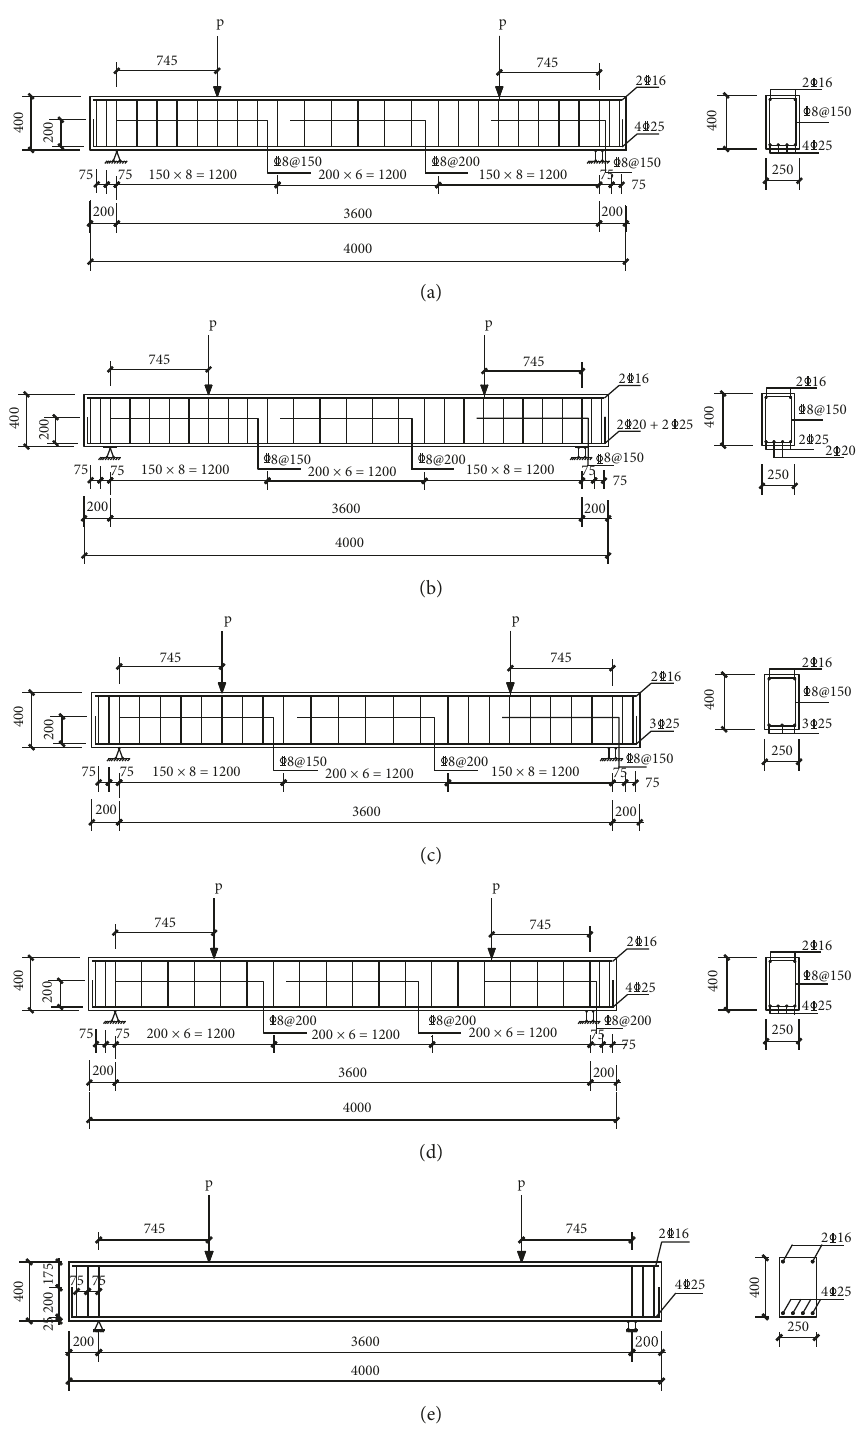
Figure 1: Dimensions and reinforcement details (dimensions in mm): (a) B1, B2, (b) B3, (c) B4, (d) B5, and (e)